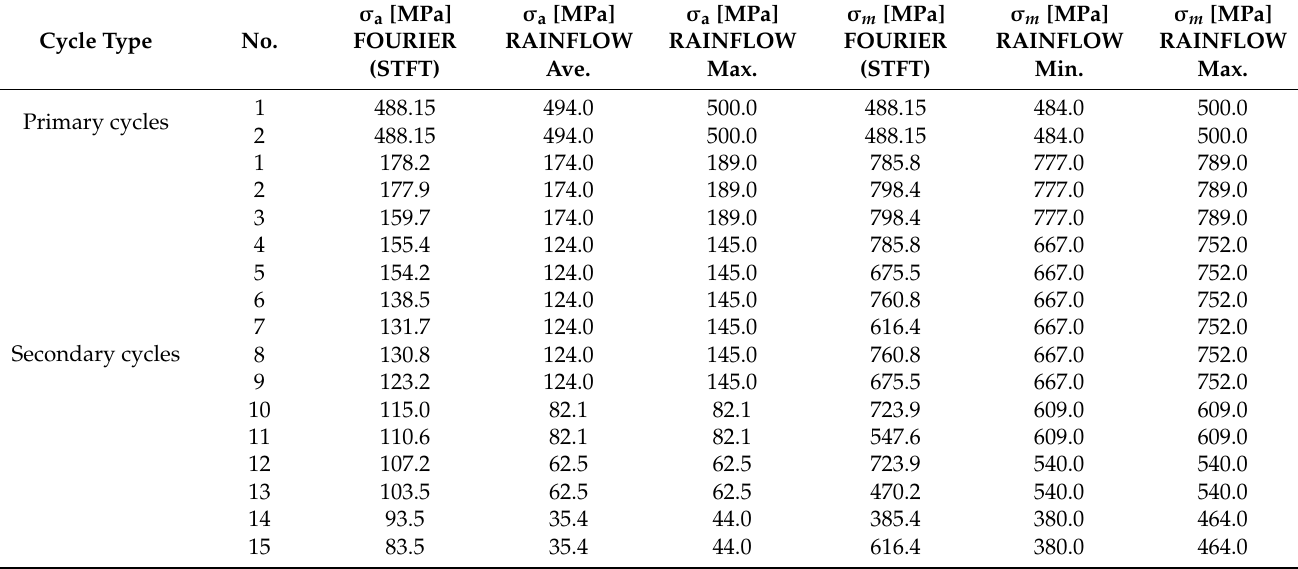
Table 2. Comparison of identified mean values and amplitudes of cycles based on rainflow and Fourier methods for stress variation defined by